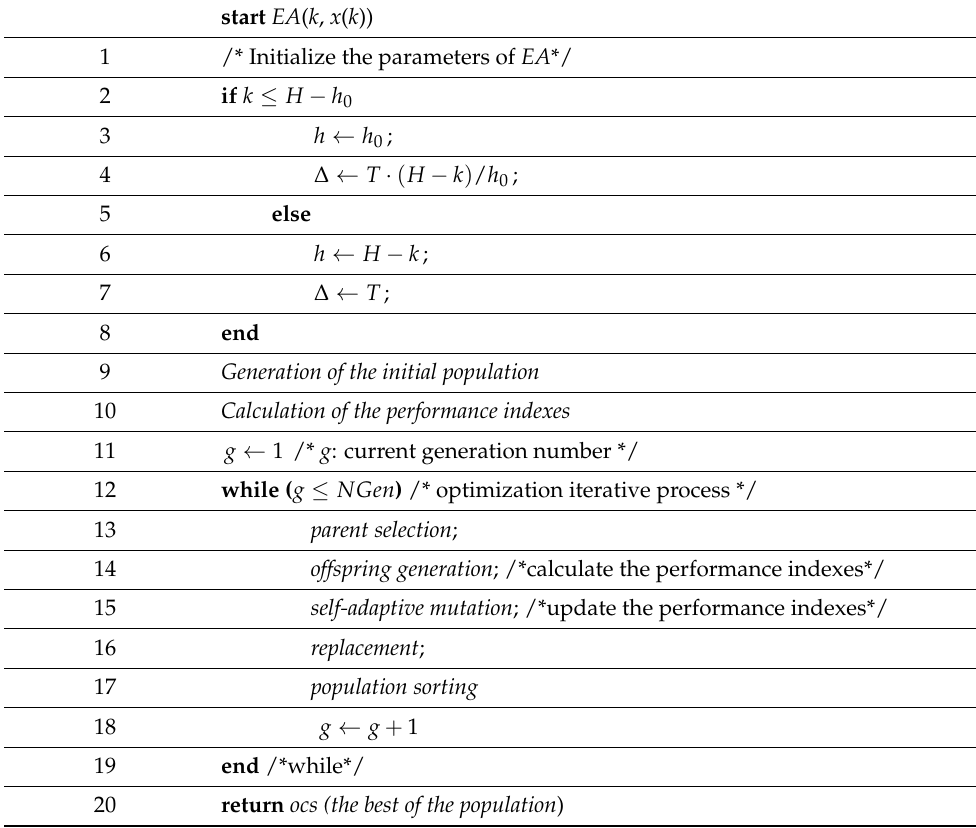
Table 2. Outline of the EAv2 with improved computational